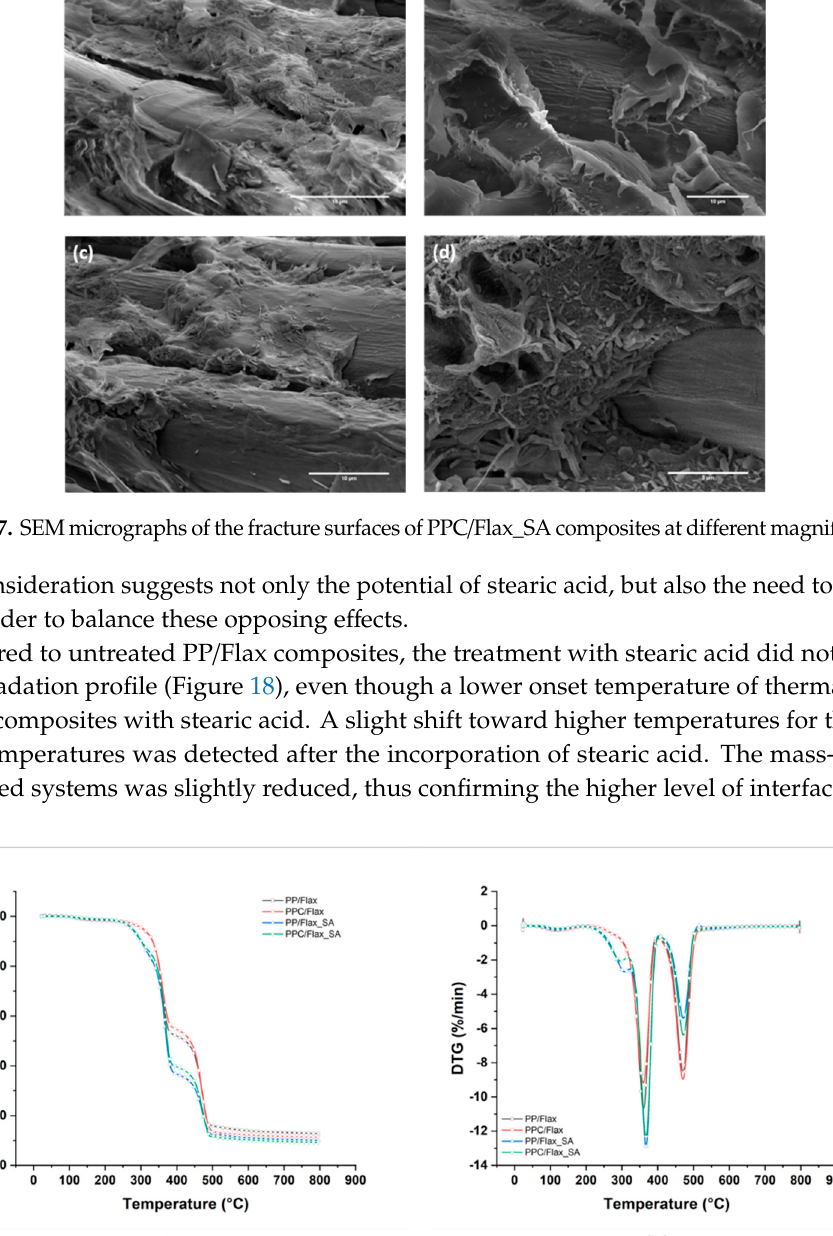
Figure 16. SEM micrographs of the fracture surfaces of PP/Flax_SA composites at different magnifications.